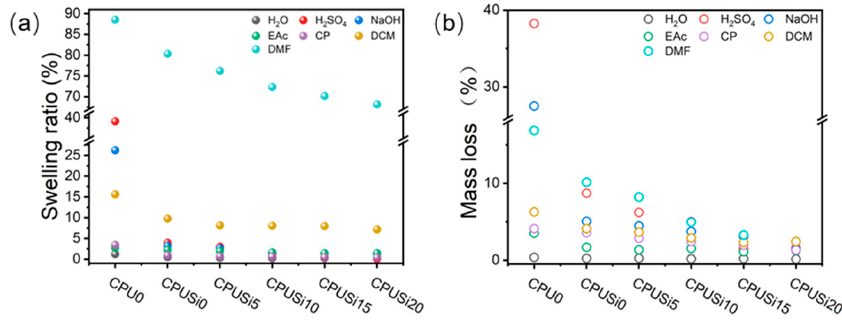
Figure 8. ( a )The swelling ratio; ( b ) The mass loss of CPU and CPUSi hybrids